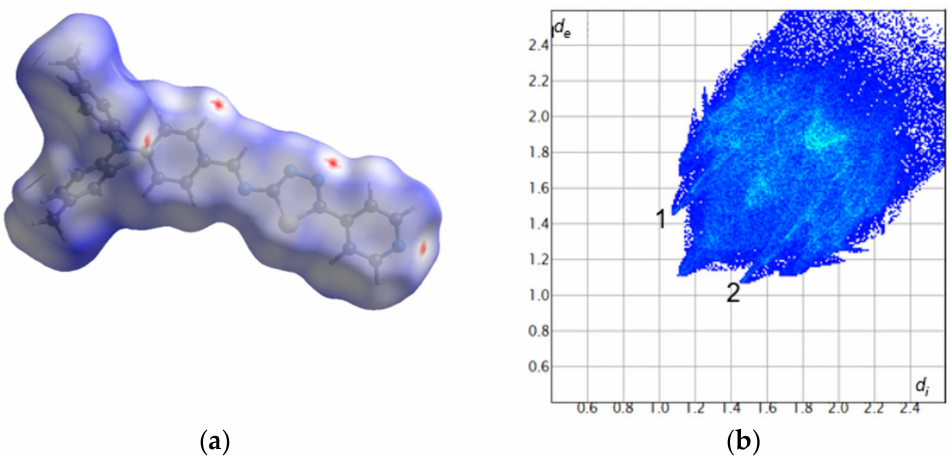
Figure 3. Hirshfeld surface ( a ) and fingerprint plot ( b ) for PPL9. The red, white, and blue colors on the Hirshfeld surface indicate contacts shorter, equal, and longer than the sum of the van der Waals radii, respectively. d e and d i —distances from a point on the surface to the nearest atom outside and inside the surface,